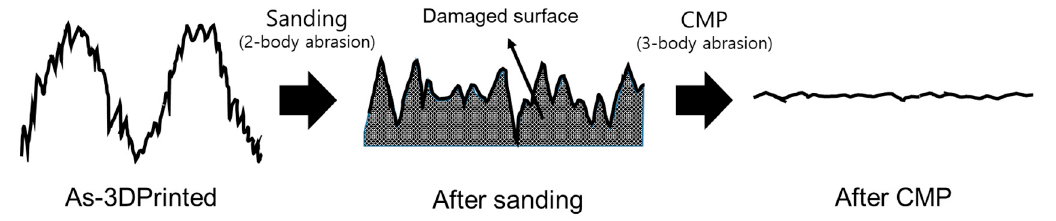
Figure 17. Schematic diagram of the two-step polishing mechanism.